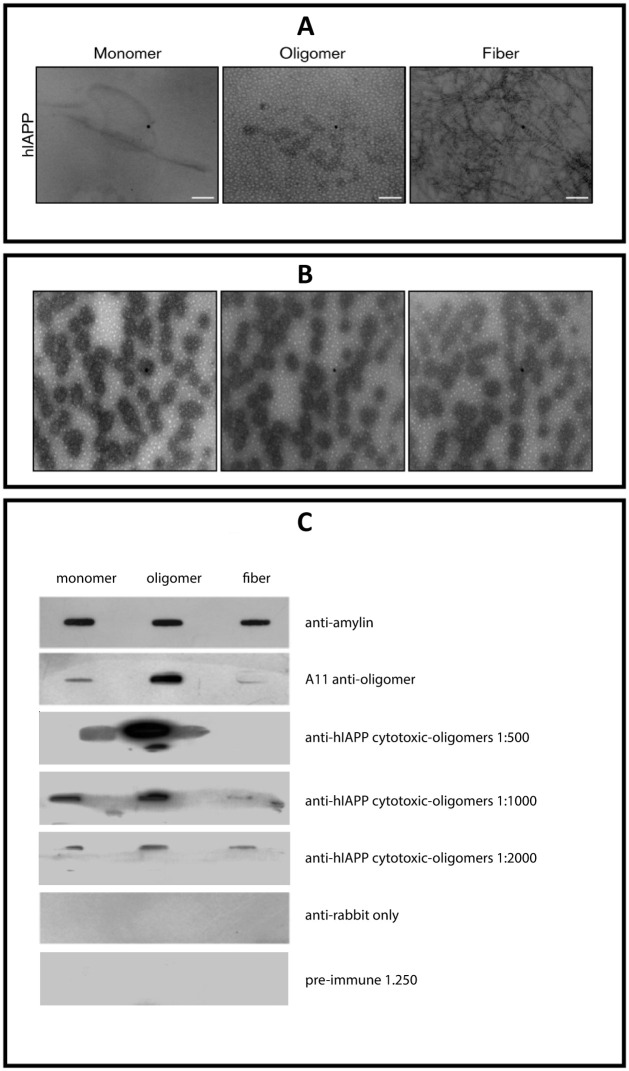
Production and characterization of novel polyclonal anti-hIAPP cytotoxic oligomers antibody (MEX1).A). Representative negative-stain TEM images of monomers, spherical and cytotoxic oligomers and fibrils of synthetic hIAPP used in the production and characterization experiments of the novel polyclonal antibody. Scale bar, 200 nm. B). Antigen characterization. Representative electron microscopy images of the antigen and adjuvant used in the production of anti-hIAPP cytotoxic oligomer polyclonal antibodies. C). Slot blot analysis of monomers, oligomers and fibrils of synthetic hIAPP. Anti-amylin antibody binds to the amino terminus of the three species (monomer, oligomers and fibrils). hIAPP oligomers only stain with anti-oligomer (A11) antibody and the novel anti-hIAPP cytotoxic oligomer polyclonal antibody (MEX1). The synthetic hIAPP oligomers reacted with MEX1 which indicates that is specific to the oligomeric conformation and has no reactivity toward monomers or fibrils.